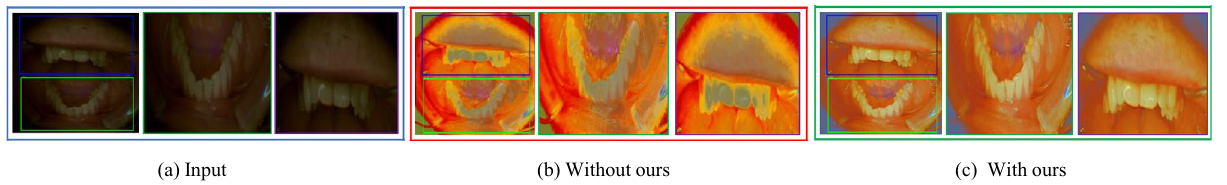
Figure 4. ( a ) Input images are shown with zoomed fragments, ( b ) shows the results without-ours method and ( c ) shows the results with ours method.